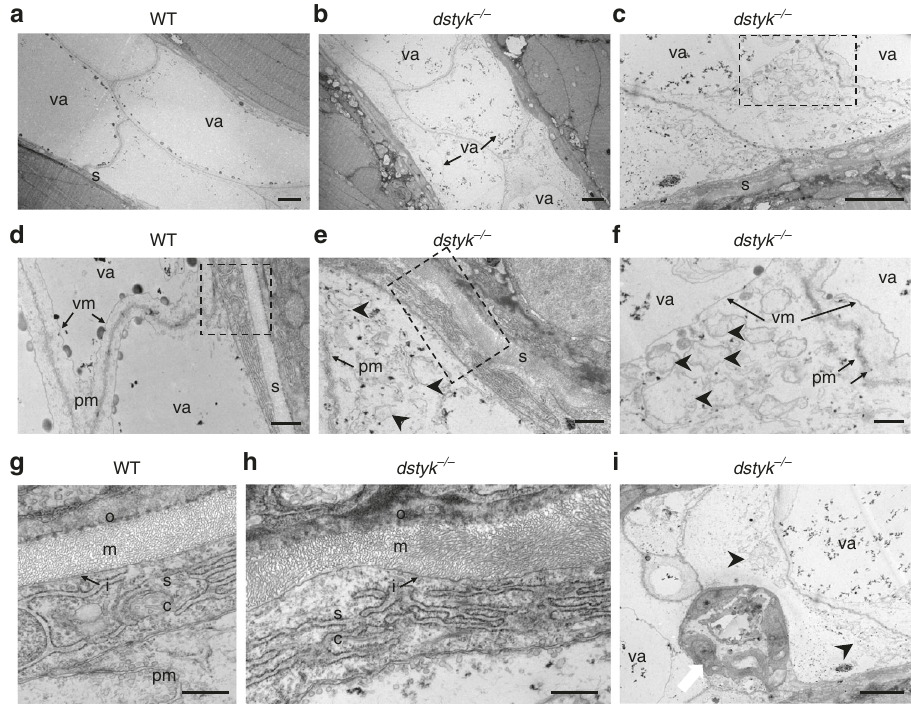
Fig. 6 Ultrastructure of the notochord and notochord sheath in WT and dstyk mutant. a – f The transmission electron micrographs of the notochord in WT ( a , d ) and dstyk mutant ( b , c , e and f ) at 48 hpf. Note that the vacuoles were smaller in the dstyk mutant, and there were many scatteredly distributed small vesicles that were wrapped by single layer membrane in the cytoplasm of dstyk mutant. g , h The ultrastructure of the notochord sheath in the WT ( g ) and dstyk mutant ( h ). Note the straight, well-organized sheath layer in the WT and wavy, disordered organization of the medial layer in the dstyk mutant. i Ultrastructure of the notochord showed not well vacuolated epithelia-like cells (white arrow) aggregated in dstyk mutant. f , g and h were magni fi ed image of the dotted boxes in c , d and e , respectively. Black arrowheads indicate many small vesicles in the mutant cytoplasm. All images are shown longitudinal sections. The scale bars represent ( a – c , and i ) 5 µ m, ( d – f ) 1 µ m and ( g , h ) 500 nm. va, vacuole; s, notochord sheath; sc, sheath cell; pm, plasma membrane; vm, vacuole membrane; i, inner laminin-rich layer, m, medial layer, and o, outer collagen-rich layers of the notochord